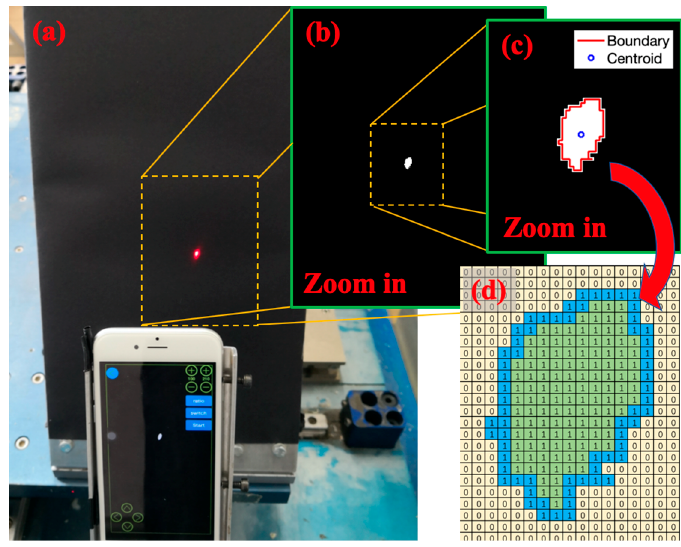
Figure 1. Image processing principle explanation: ( a ) Laser spot on a projection plate; ( b ) Gray processing and binarization processing; ( c ) Boundary detection and centroid calculation; ( d ) The value of the laser spot after binarization processing.